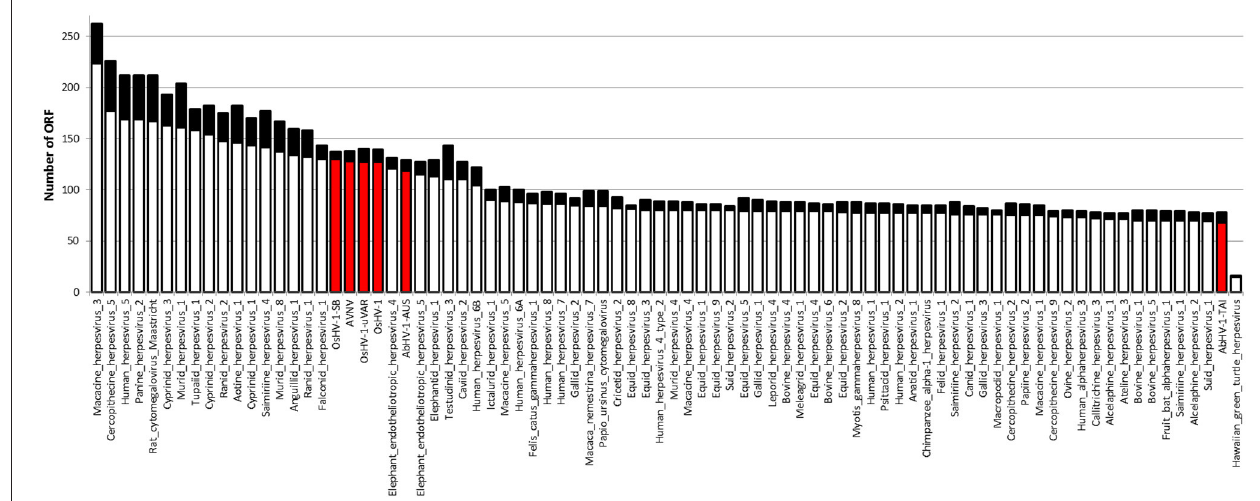
Frontiers in Microbiology |